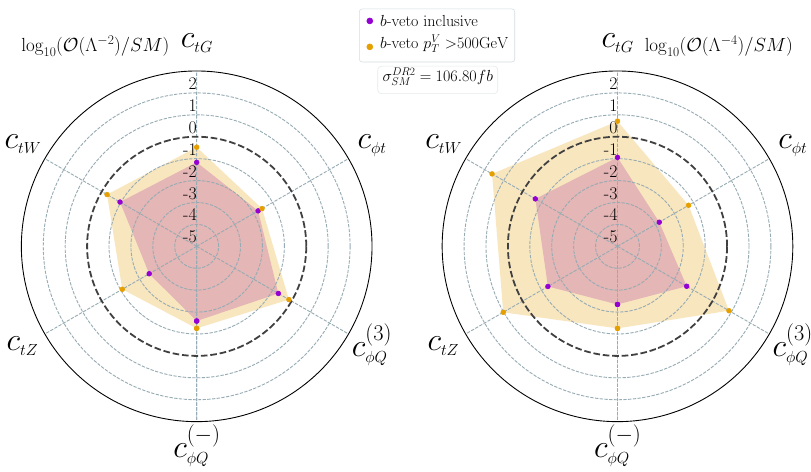
Figure 8 . Relative impact of the linear ( left ) and quadratic ( right ) SMEFT contributions to the tWZ process at NLO accuracy in QCD, applying our DR2 overlap removal and a veto on central ( | η | < 2 . 5 ) or hard ( p T > 30 GeV) b -jets. They are obtained by dividing the cross section contributions over the inclusive (magenta) and high-energy (orange) phase-space regions by the corresponding SM prediction. The high-energy phase-space region is defined by requiring both the W and Z boson p T to be greater than 500 GeV.